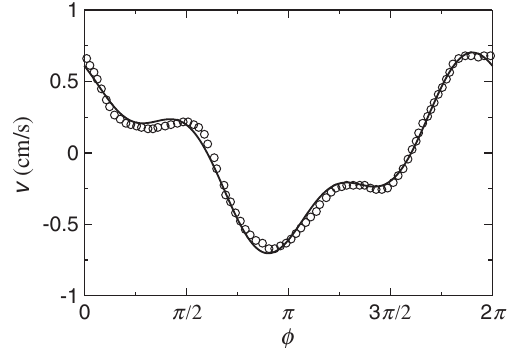
FIG. 2. Droplet velocity v as function of the phase shift (cid:3) between the horizontal and vertical vibrations of the plate. Symbols represent experimental data from Fig. 3, upper panel, (cid:9) m , of Ref. [33]. The line represents the fit of the curve A h ¼ 240 v ð (cid:3) Þ ¼ 0 : 5435 cos ð (cid:3) (cid:1) 0 : 0211 Þ þ 0 : 1972 cos ð 3 (cid:3) þ 1 : 2267 Þ